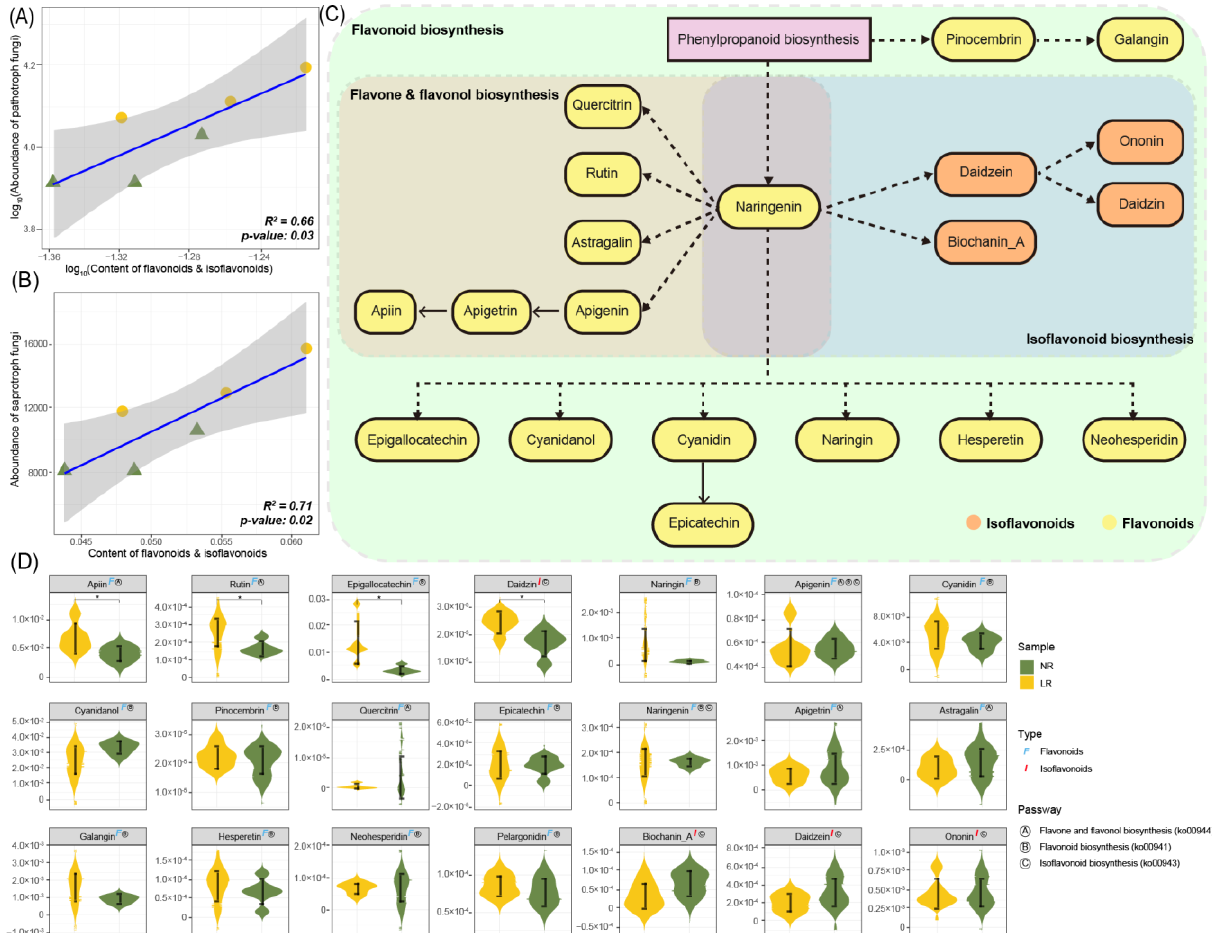
Figure 10. Differences in flavonoids in highbush blueberry roots. NR-rhizosphere soil of normally growing plants; LR-rhizosphere soil of plants with limited growth. * significant difference ( p ≤ 0.05). The error bar represents the standard error of three replicates. ( A ) A linear relationship between the abundance of pathogenic fungi in rhizosphere soil and content of flavonoids in roots. ( B ) A linear relationship between abundance of saprotrophic fungi in rhizosphere soil and content of flavonoids in roots. ( C ) Links among biosynthetic pathways of various flavonoids. ( D ) Differences in root content of flavonoids between blueberry plants with normal and restricted growth.